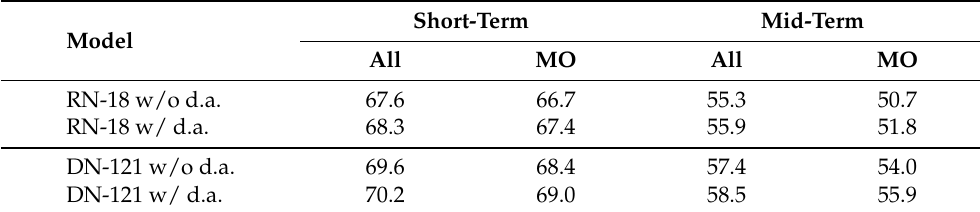
Table 7. Ablation of data augmentation during forecasting training.